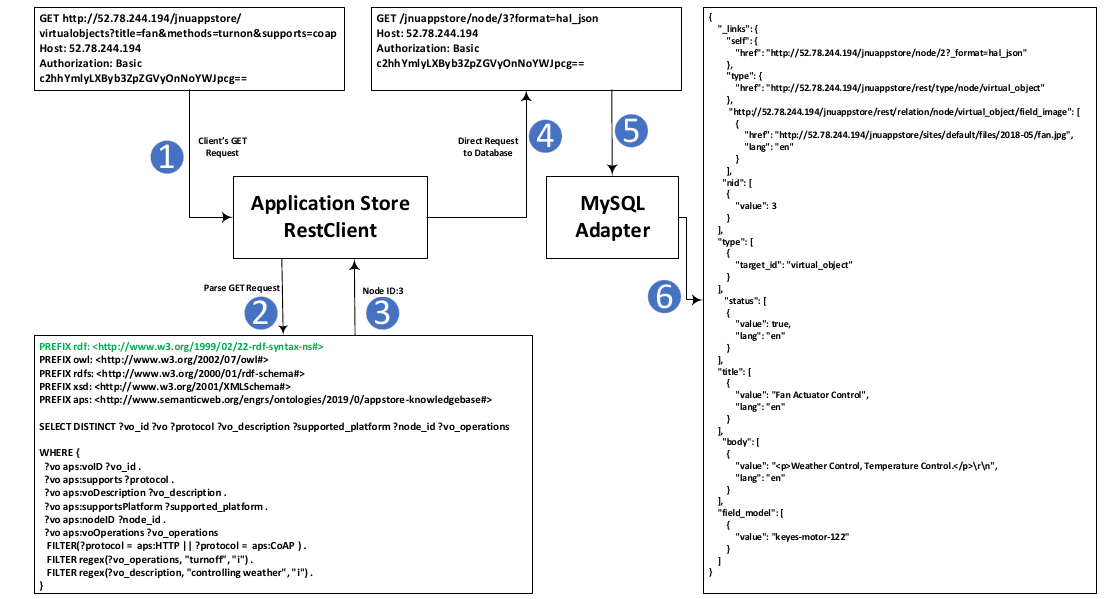
Figure 7. Virtual object discovery mechanism using application store RestClient and semantic